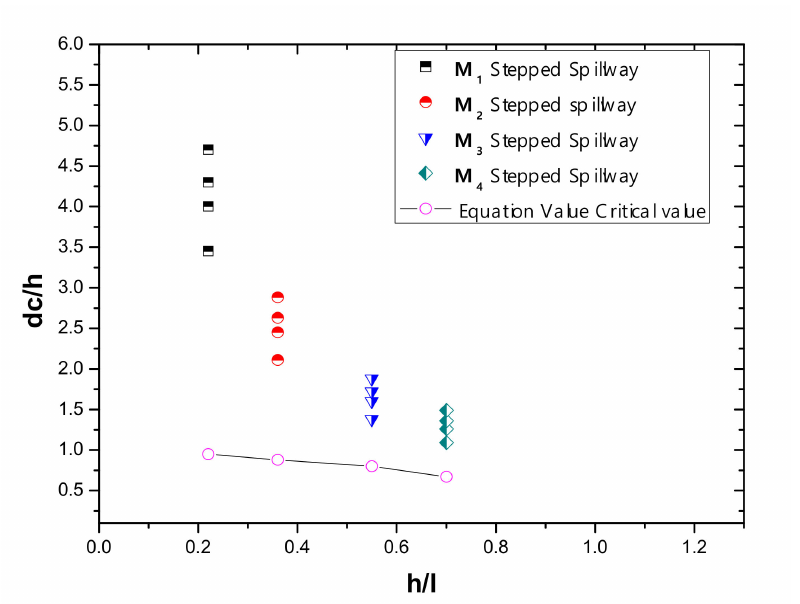
Figure 4. Variation of relative critical depth (dc/h) of different slope stepped spillway with (h/l) values with critical values (derived from the